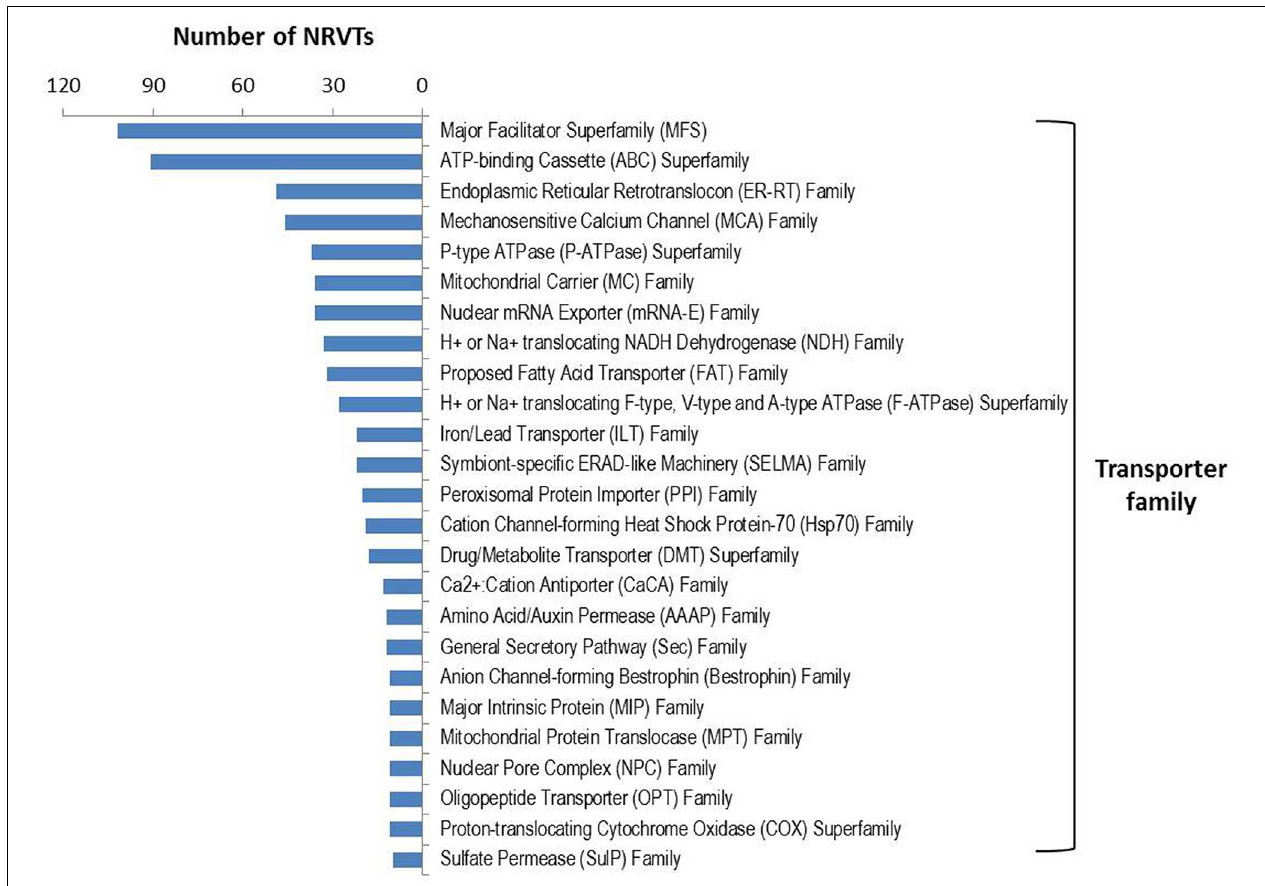
FIGURE 3 | Transporter family distribution in GiroV1. A total of 934 NRVTs were found to encode for putative transporters among 104 families or superfamilies using blastx searches against the Transporter Classification Database. Only transporter families encoded by more than 10 NRVTs are shown.